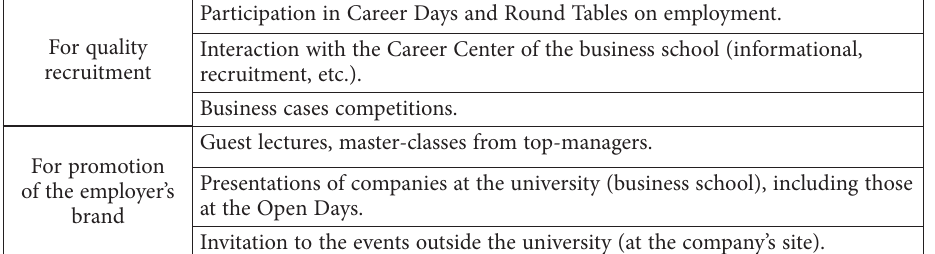
Table 2. The most attractive business school’s activities for the partner companies (source: created by authors) Participation in Career Days and Round Tables on For quality recruitment